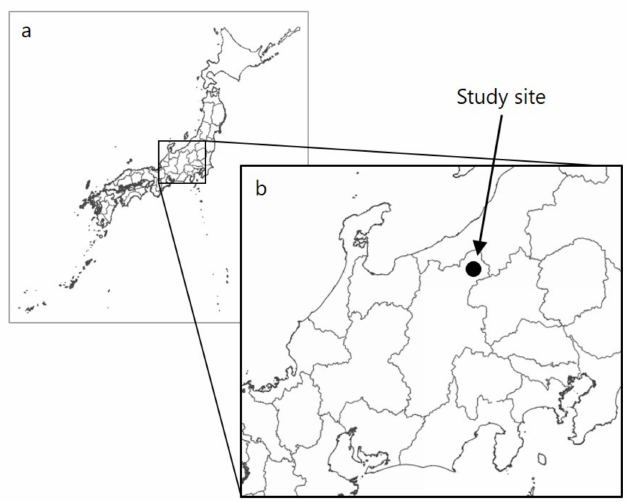
Figure 1. Study site ( a ): the map of Japan ( b ): study